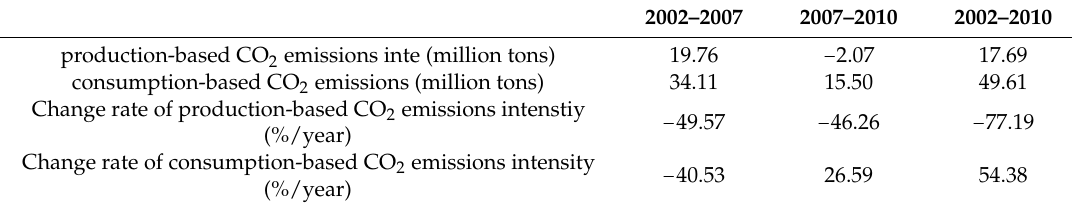
Table 4. Comparison of change rates between production-based and consumption-based CO 2 emissions